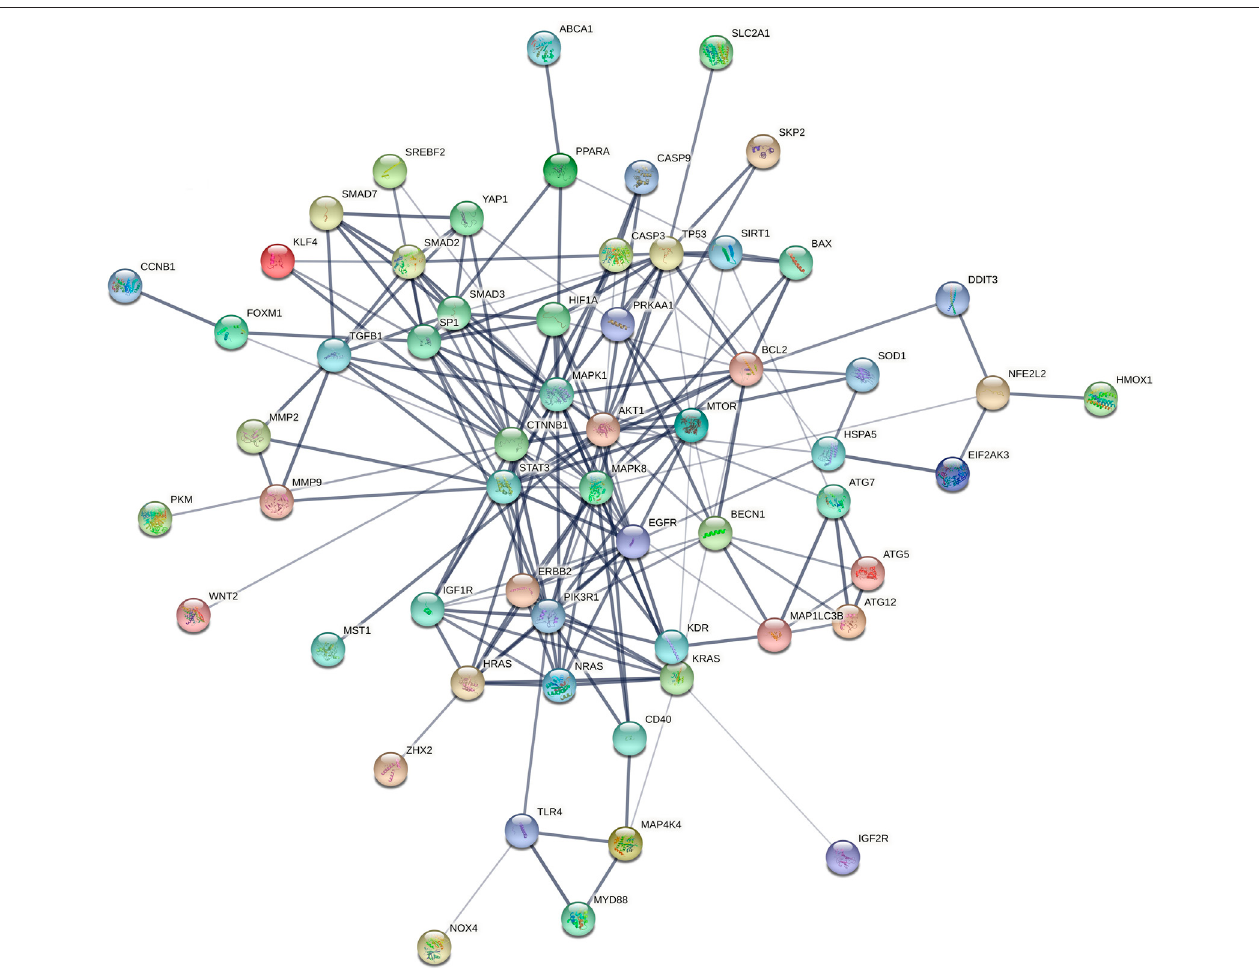
FIGURE 3 | PPI network using the reported targets for Tan IIA (2015 – 2021). Network nodes (color balls with 3D protein structure known or predicted) represent targetproteins.Edges(lines)representprotein-proteinassociationsandlinethicknessindicatesthestrengthofdatasupport(thethickertheline,thegreaterthestrength).